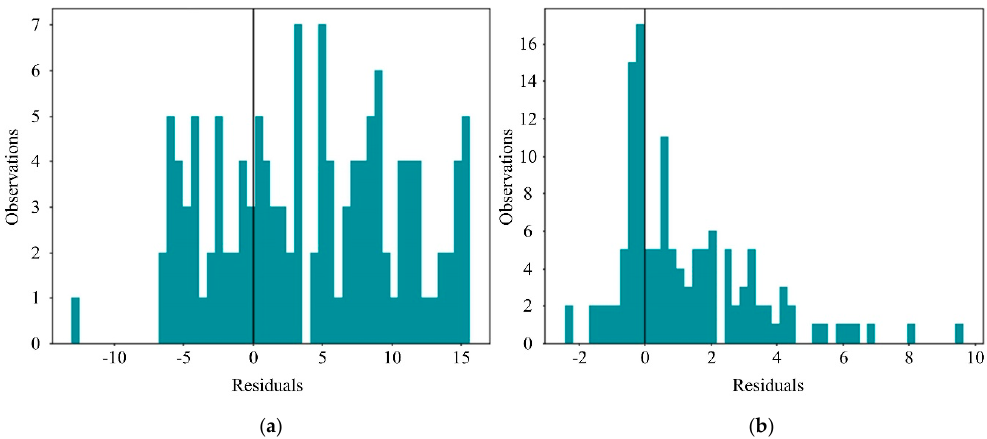
Figure 9. Error histograms of predictions from di ff erent group. ( a ) LightGBM with raw feature. ( b ) LightGBM with secondary extraction feature.